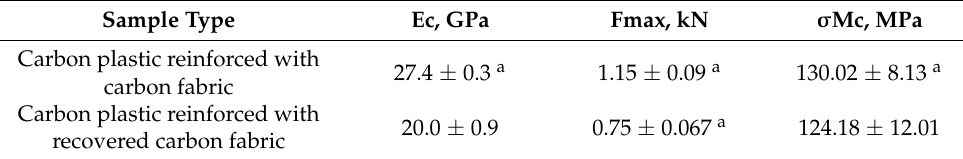
Table 5. Effective mechanical characteristics of carbon fiber samples.